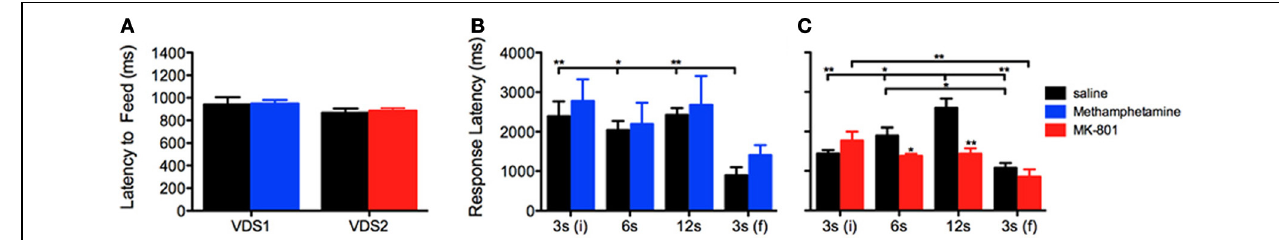
FIGURE 3 | Methamphetamine and MK-801 influence on (A) latency to feed and (B,C) response latency measures. Statistically significant comparisons between delay segments are marked with a horizontal line over